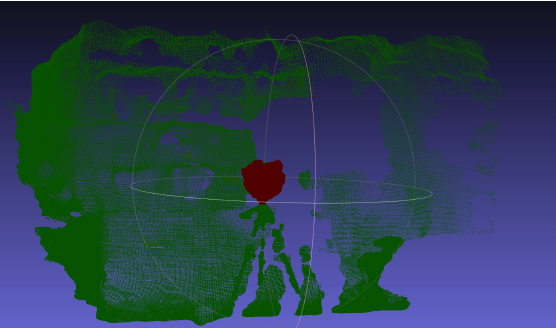
Figure 17. Basketball correctly detected in the second experiment.